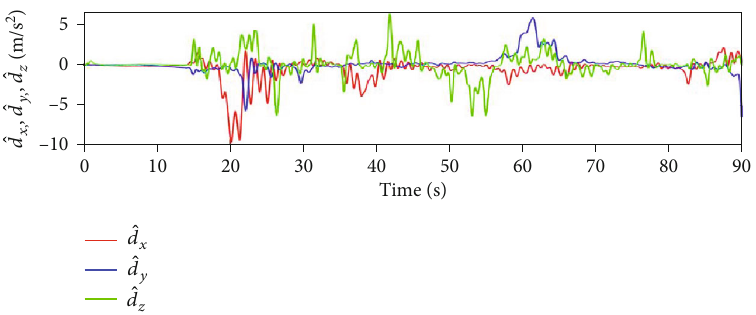
obtained by the SMBF: fl ight scenario 1. P ,1